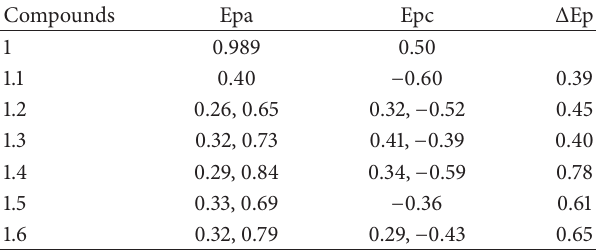
Table 3: Electrochemical properties of the compounds